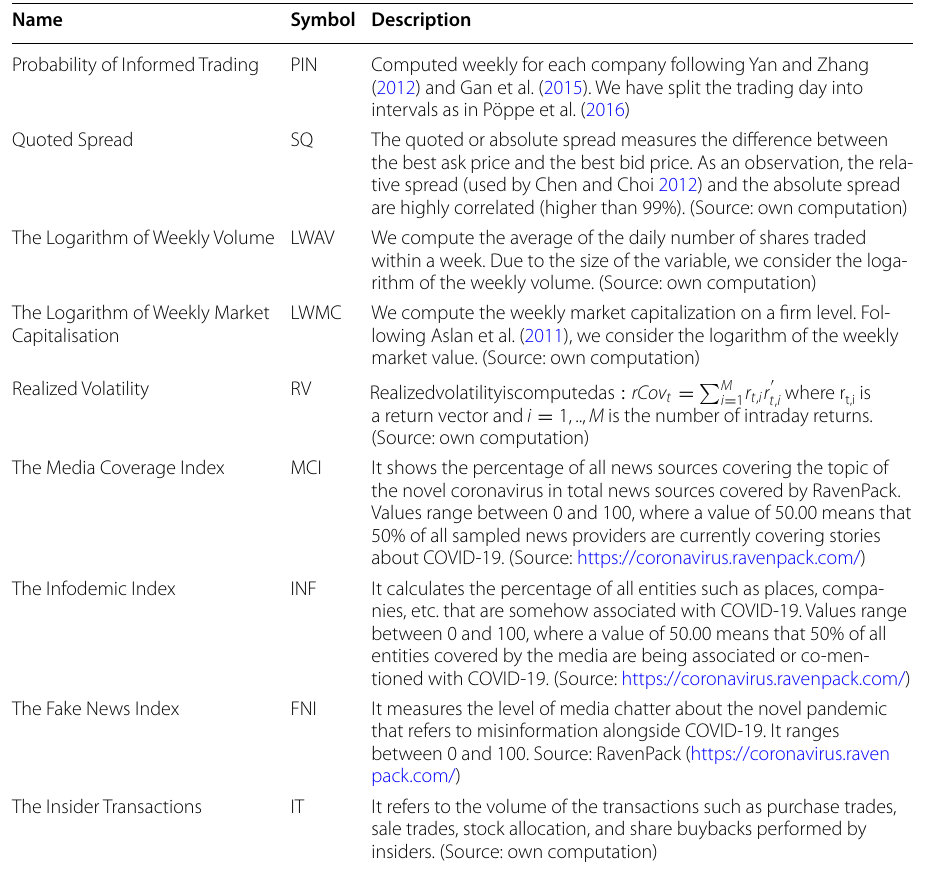
Table 3 Description of the